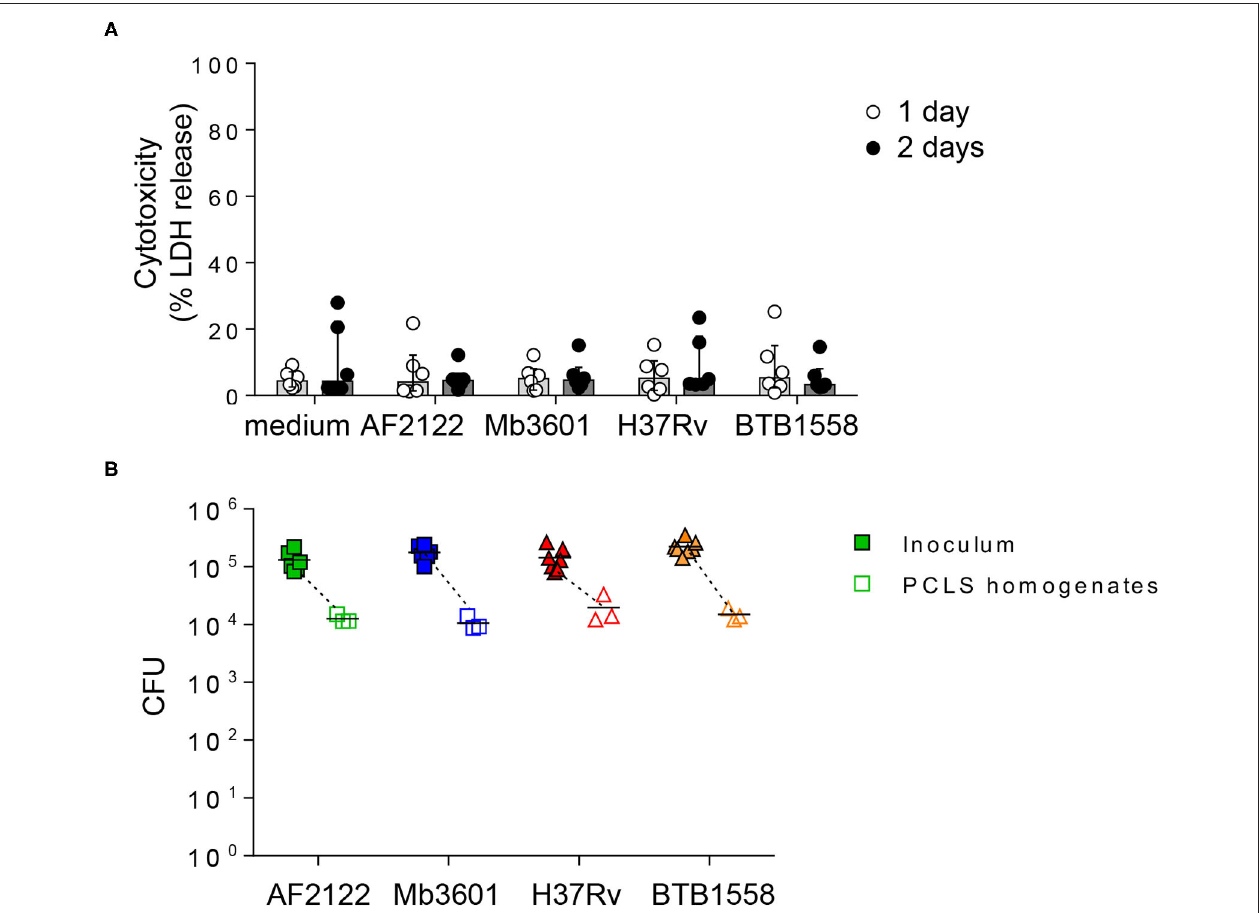
FIGURE 1 | Precision-cut lung slice (PCLS) infection with four different Mb or Mtb strains does not induce lung tissue cytotoxicity, and equivalent numbers of bacilli are recovered 24h post-infection. (A) PCLS prepared from Blonde d’Aquitaine lungs post-mortem were infected with 10 5 CFU of two Mb strains (AF2122 or Mb3601) or two Mtb strains (H37Rv or BTB1558). After 1 and 2 days post-infection, the PCLS supernatants were harvested, and tissue was homogenized. Lactate dehydrogenase (LDH) was measured in both compartments using the “non-radioactive cytotoxicity assay” kit. Cytotoxicity was determined as (%) = (O.D. 490nm LDH in supernatant)/(O.D. 490nm LDH in supernatant + O.D. 490nm LDH in PCLS homogenates) × 100. Individual data and the median and interquartile range in each group are presented ( n = 6 animals from six independent experiments). (B) At 24h post-infection, the PCLS were washed and homogenized to recover bacilli. The inoculum and PCLS homogenates were serially diluted and plated with colony-forming units numerated after 3–6 weeks of incubation. Individual data and the mean in each group are presented ( n = 6 independent inocula prepared; PCLS homogenates data represent the mean of technical duplicates from n = 3 animals from three independent